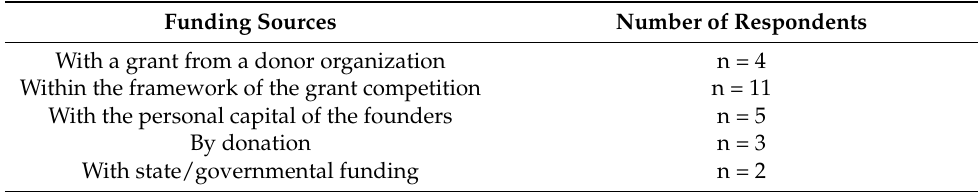
Table 2. How was financed the creation of your social enterprise?